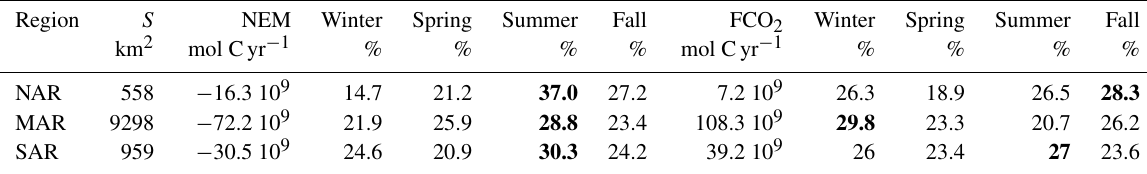
Table 5. Seasonal contribution to FCO 2 and NEM in each subregion. The seasons displaying the highest percentages are indicated in bold. Winter is defined as January, February, and March; spring is defined as April, May, and June, and so on. Region S NEM Winter Spring Summer Fall FCO 2 Winter Spring Summer Fall km 2 mol Cyr − 1 %